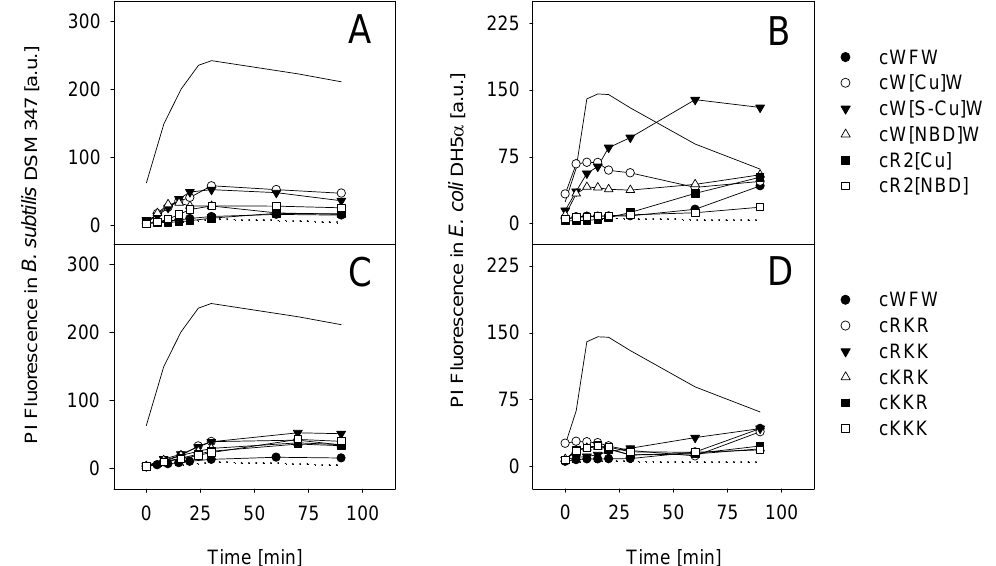
Figure 4. Bacterial membrane permeabilisation determined with flow cytometry using propidium iodide (PI). PI influx after incubation with cWFW, fluorescent-labeled and K-substituted cyclic hexapeptides was tested into B. subtilis DSM 347 ( A , C ) and E. coli DH5 α ( B , D ) at respective MICs. The antibiotic polymyxin B (5 µM) and the helical model peptide KLA-1 (KLALKLALKALKAALKLA-NH , 5 µM) obtain a high 2 membrane permeabilising potential and served as positive control in Gram-negative and Gram-positive cells, respectively (solid line) [20,34]. Preparations without peptide were used as negative control (dotted